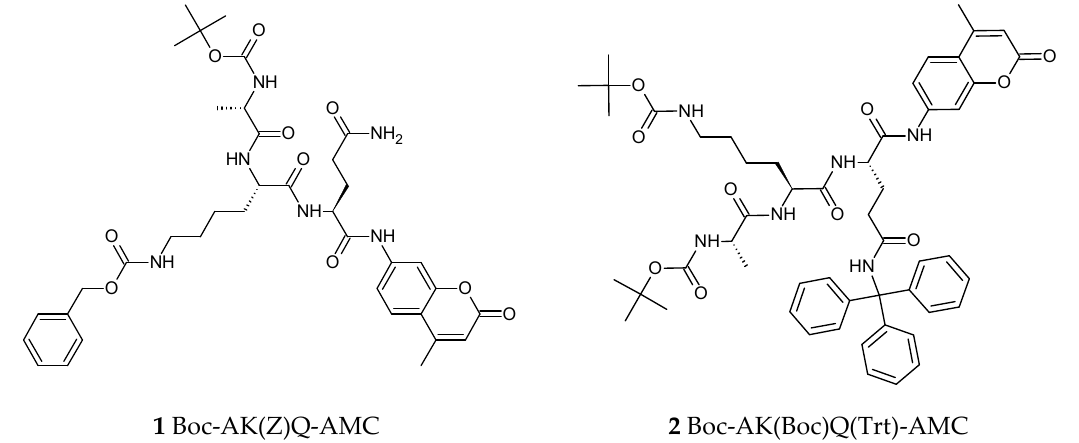
Table 2. Fluorogenic substrates successfully isolated and their overall percentage